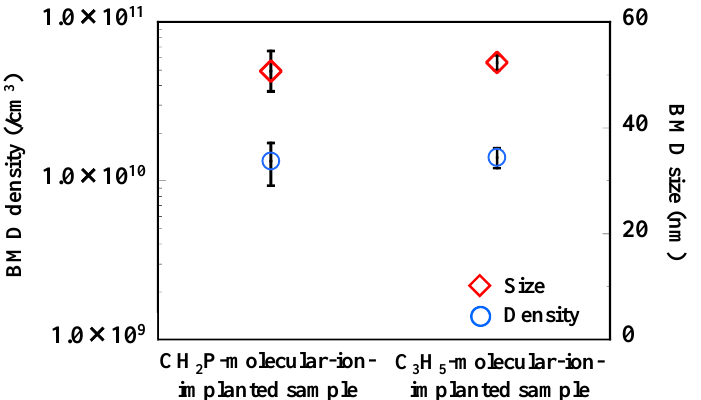
Figure 5. Cross-sectional BMD density and size determined by optical microscopy observant ion of CMOS images sensor fabricated with CH 2 P- and C 3 H 5 -molecular-ion-implanted epitaxial silicon wafers.